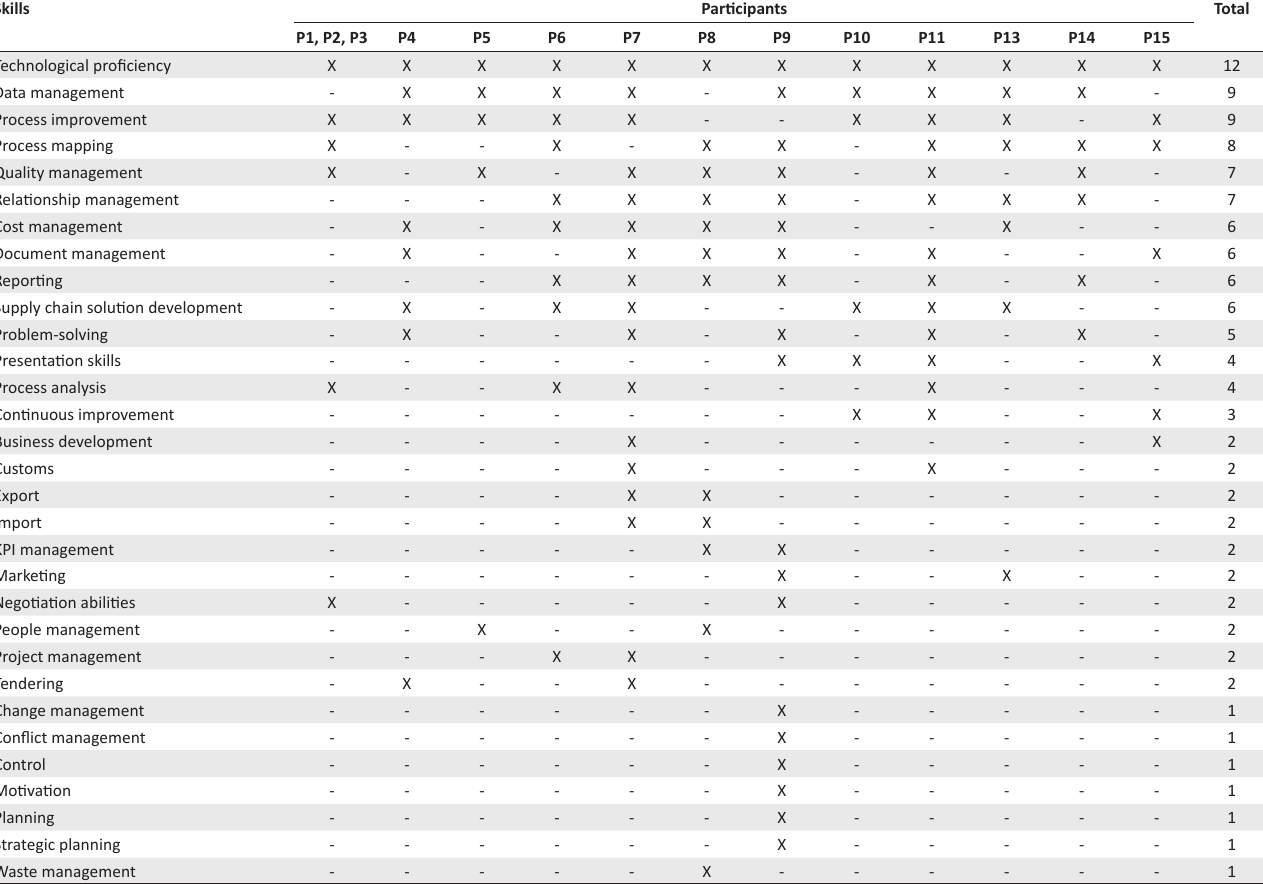
TABLE 7: The industry’s expectation concerning general supply chain management skills.